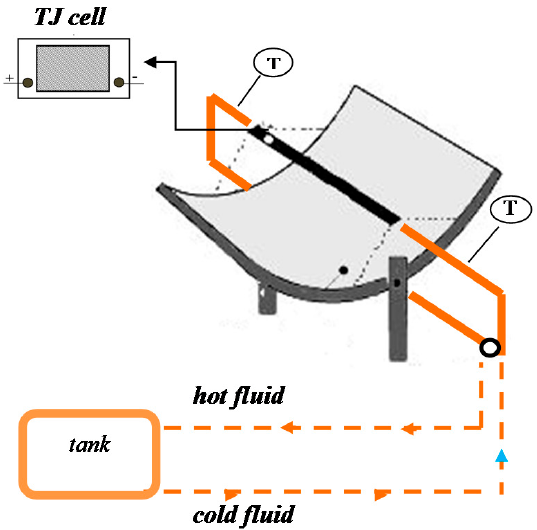
Figure 1. Concentrating photovoltaic and thermal (CPV/T) system.